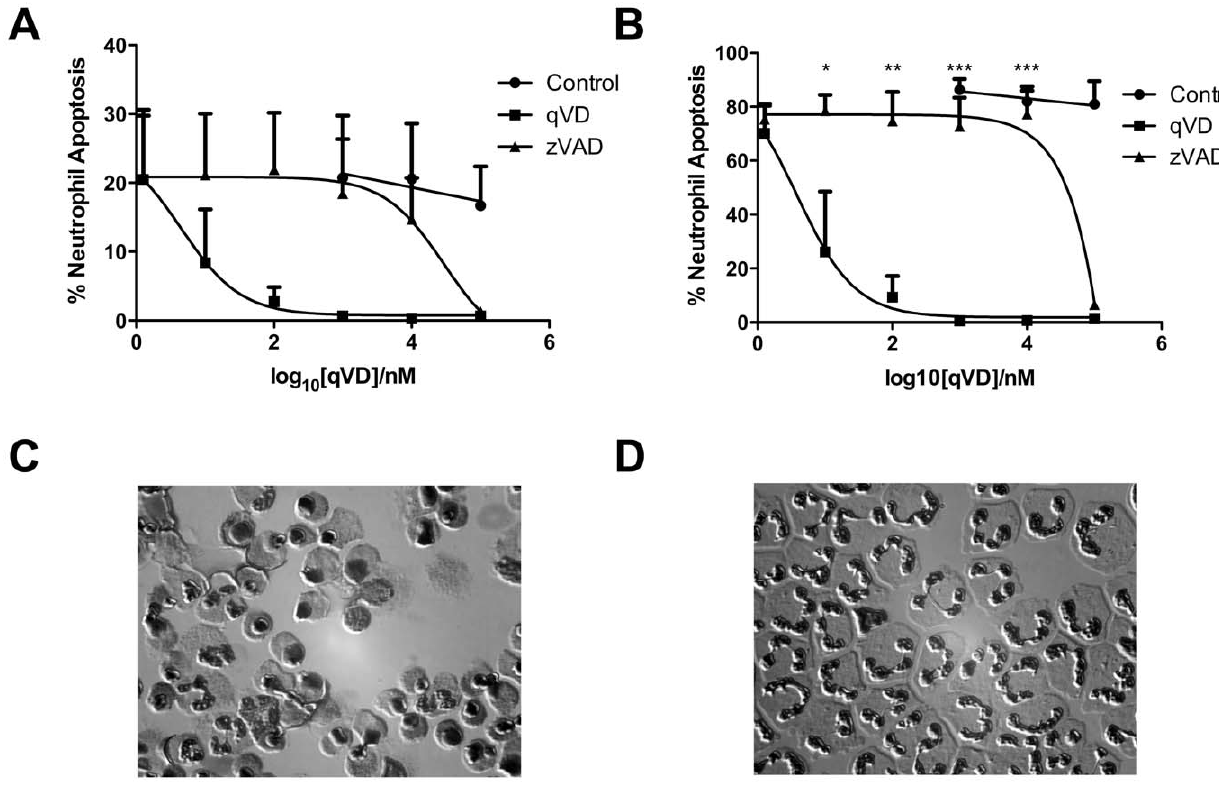
Figure 1. The caspase inhibitor Q-VD.OPh profoundly inhibits neutrophil apoptosis. A,B ) Neutrophils were cultured for A) 8 hours, and B) 20 hours with and without the pan-caspase inhibitors zVAD.fmk and Q-VD.OPh with a DMSO vehicle control (n=4). Q-VD.OPh dramatically decreased neutrophil apoptosis from 10 nM, whereas no effects of zVAD were seen below 100 m M. *P , 0.05, **P , 0.01, ***p , 0.001 for comparison of Q-VD vs zVAD, one way ANOVA with Bonferroni’s post-test correction, comparing all values. C ) Cytospin preparation of neutrophils in control conditions after 20 hours. Apoptotic cells are clearly visible by their condensed nuclei. D ) Cytospin preparation of neutrophils cultured with Q-VD.OPh after 20 hours. No apoptotic cells can be seen and neutrophils exhibit the classic polymorphic nuclear morphology of a healthy neutrophil. Images were taken using a 60 6 Plan Apo Oil immersion NA1.40, Nikon, with 1.5 6 magnification on a Nikon TE2000U.